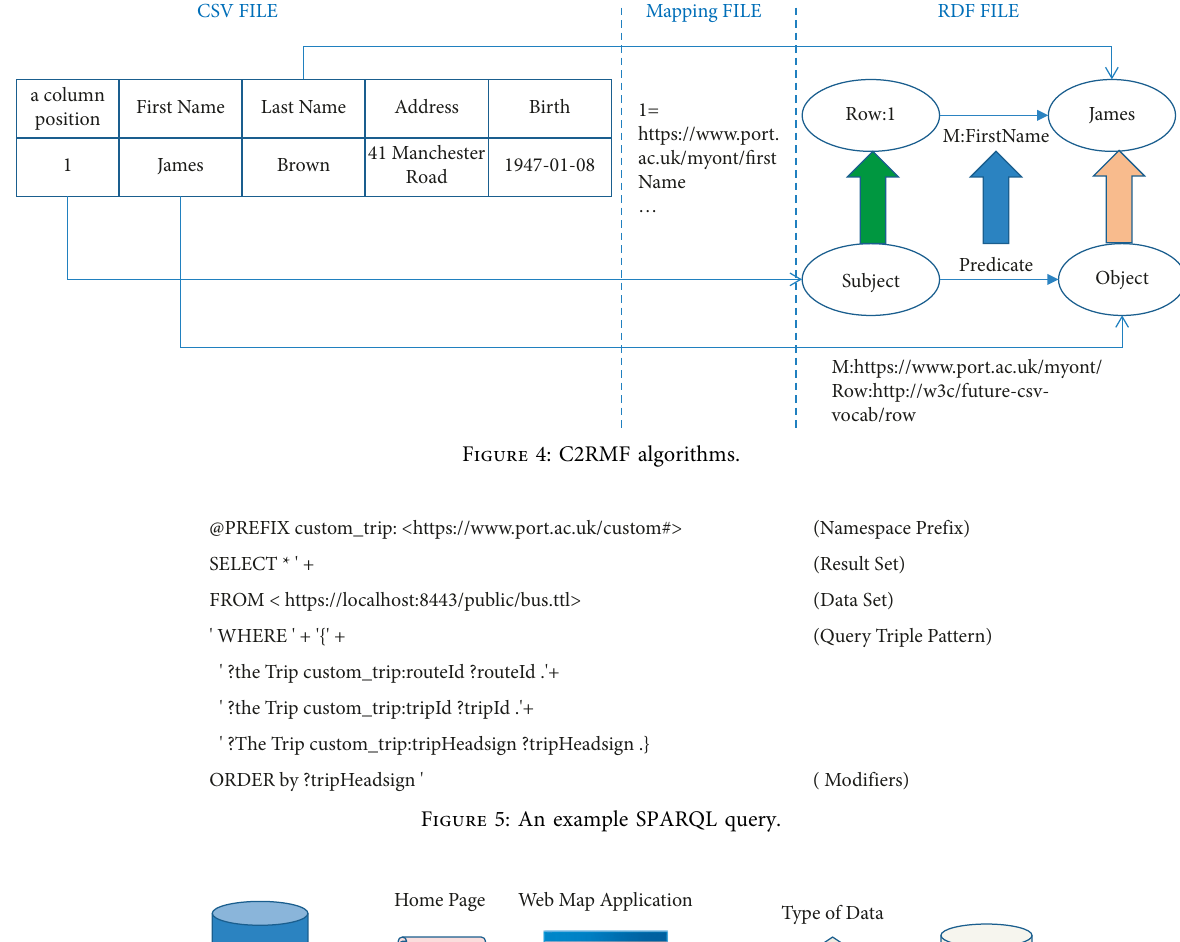
Figure 5: An example SPARQL query.